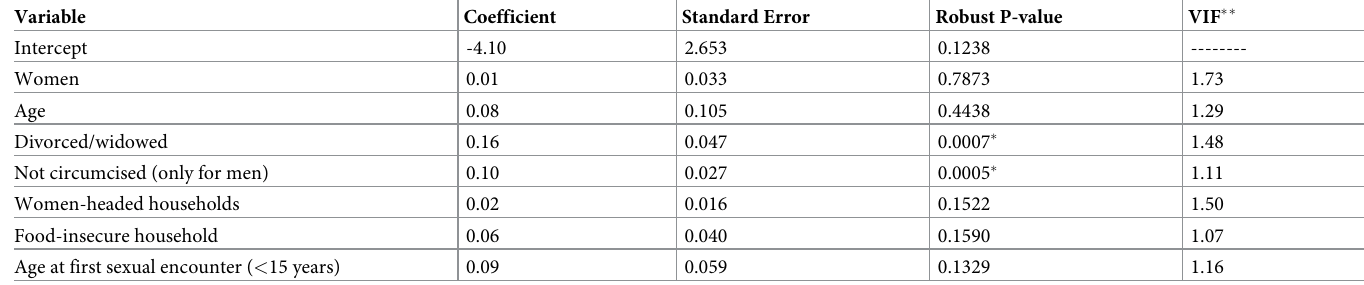
Table 2. Spatial determinants of HIV infection using ordinary least square among adults aged 15–64 years in urban Ethiopia, Ethiopia Population-based HIV Impact Assessment Survey (2017–2018).